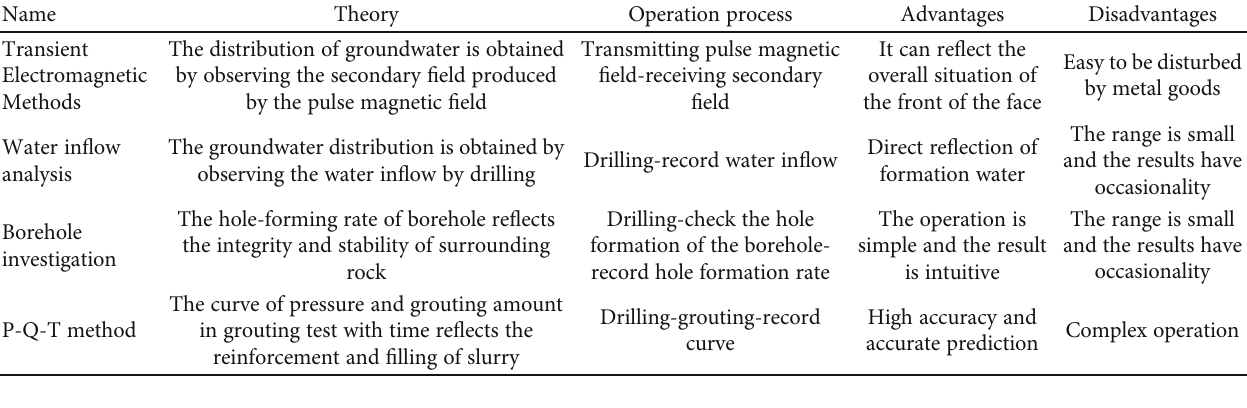
Table 1: The characteristics of the four detection methods.